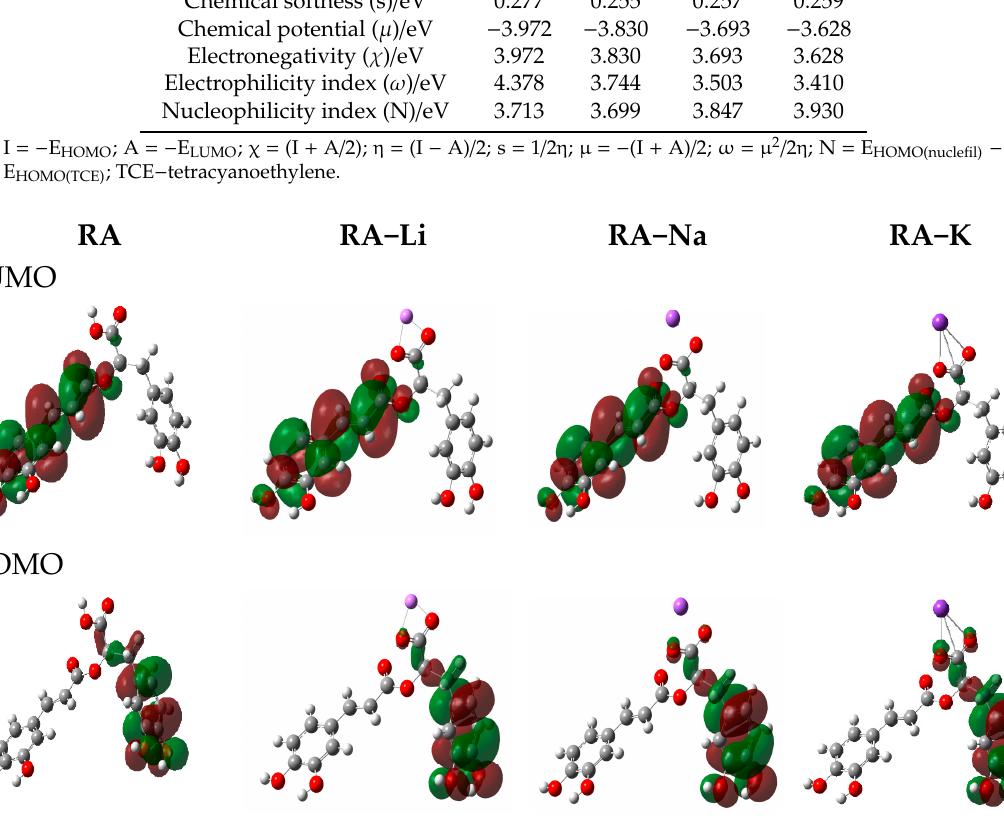
Figure 4. The HOMO/LUMO (highest occupied molecular orbital/lowest unoccupied molecular orbital) electron densities in molecules of studied compounds.